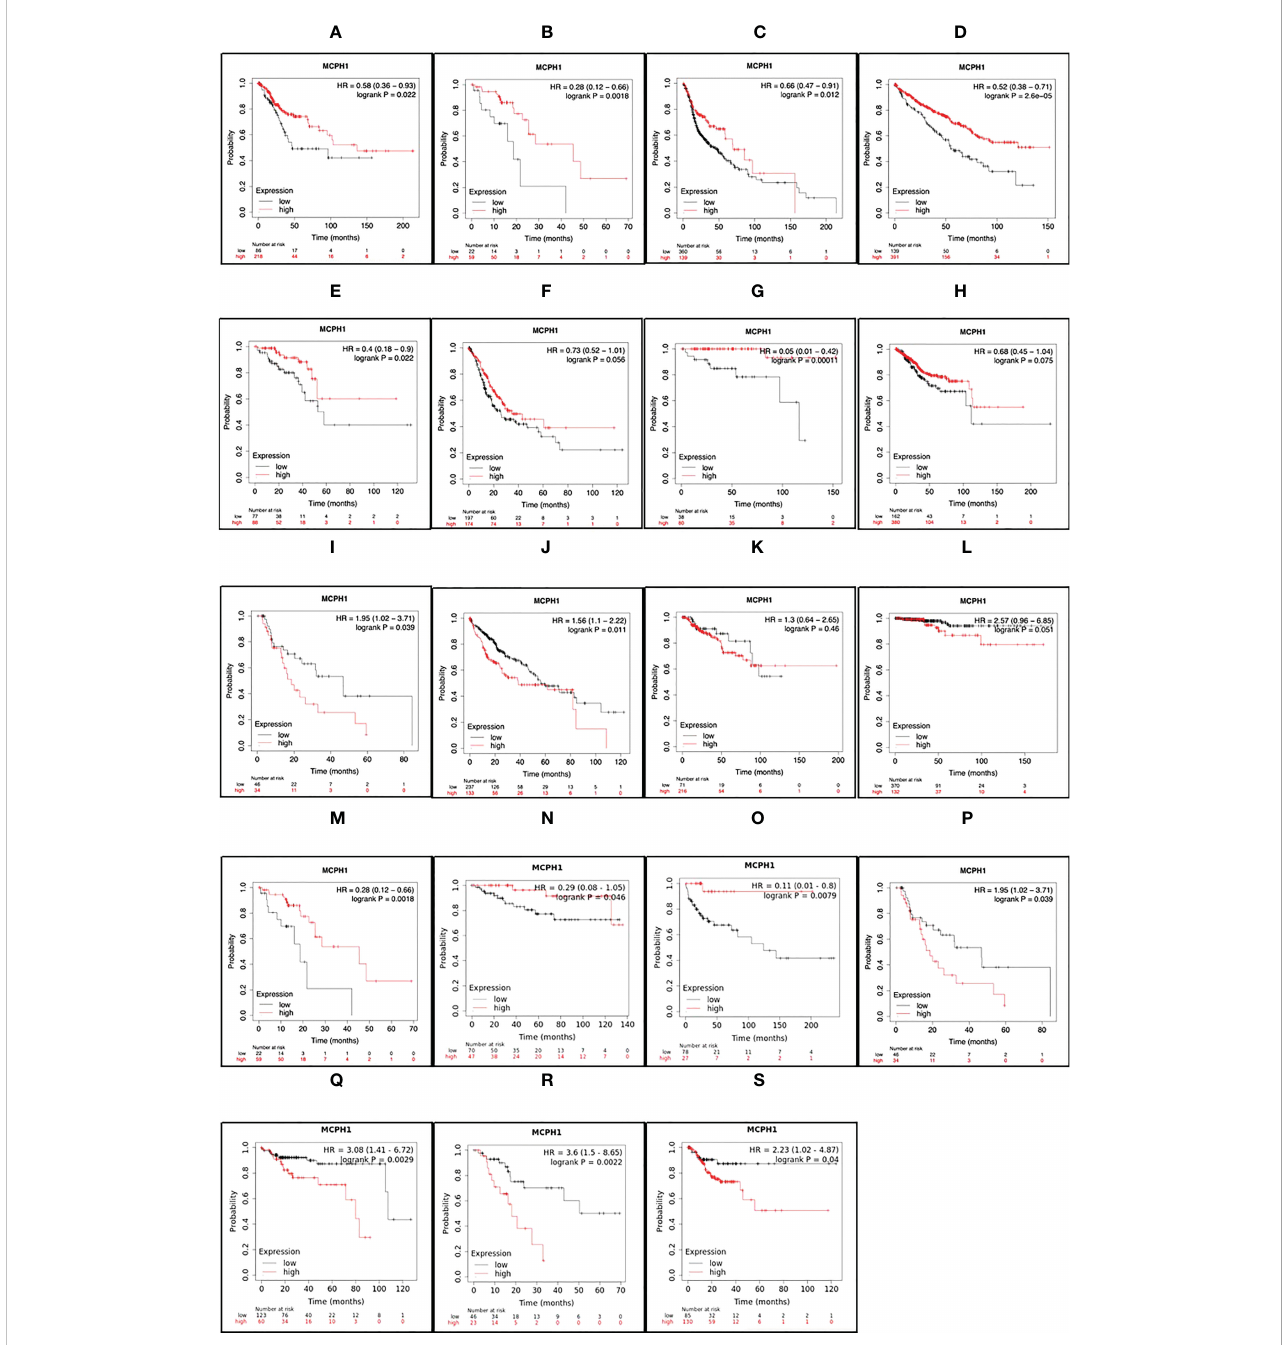
FIGURE 4 MCPH1/BRIT1 expression correlated with overall survival (OS) and relapse free survival (RFS). Low MCPH1/BRIT1 expression in cervical squamous cell carcinoma (A) , oesophageal squamous cell carcinoma (B) , head-neck squamous cell carcinoma (C) , renal clear cell carcinoma (D) , rectal adenocarcinoma (E) , stomach adenocarcinoma (F) , thymoma (G) and uterine corpus endometroid cancer (H) predicted reduced OS. High MCPH1/BRIT1 expression in oesophageal adenocarcinoma (I) , renal papillary cell carcinoma (J) , HCC (K) , and thyroid carcinoma (L) predicted reduced OS. Low MCPH1/BRIT1 expression in oesophageal squamous cell carcinoma (M) , renal clear cell carcinoma (N) and testicular germ cell tumours (O) predicted reduced RFS while high MCPH1/BRIT1 expressions in oesophageal adenocarcinoma (P) , renal papillary cell carcinoma (Q) , pancreatic ductal adenocarcinoma (R) and stomach adenocarcinoma (S) predicted reduced